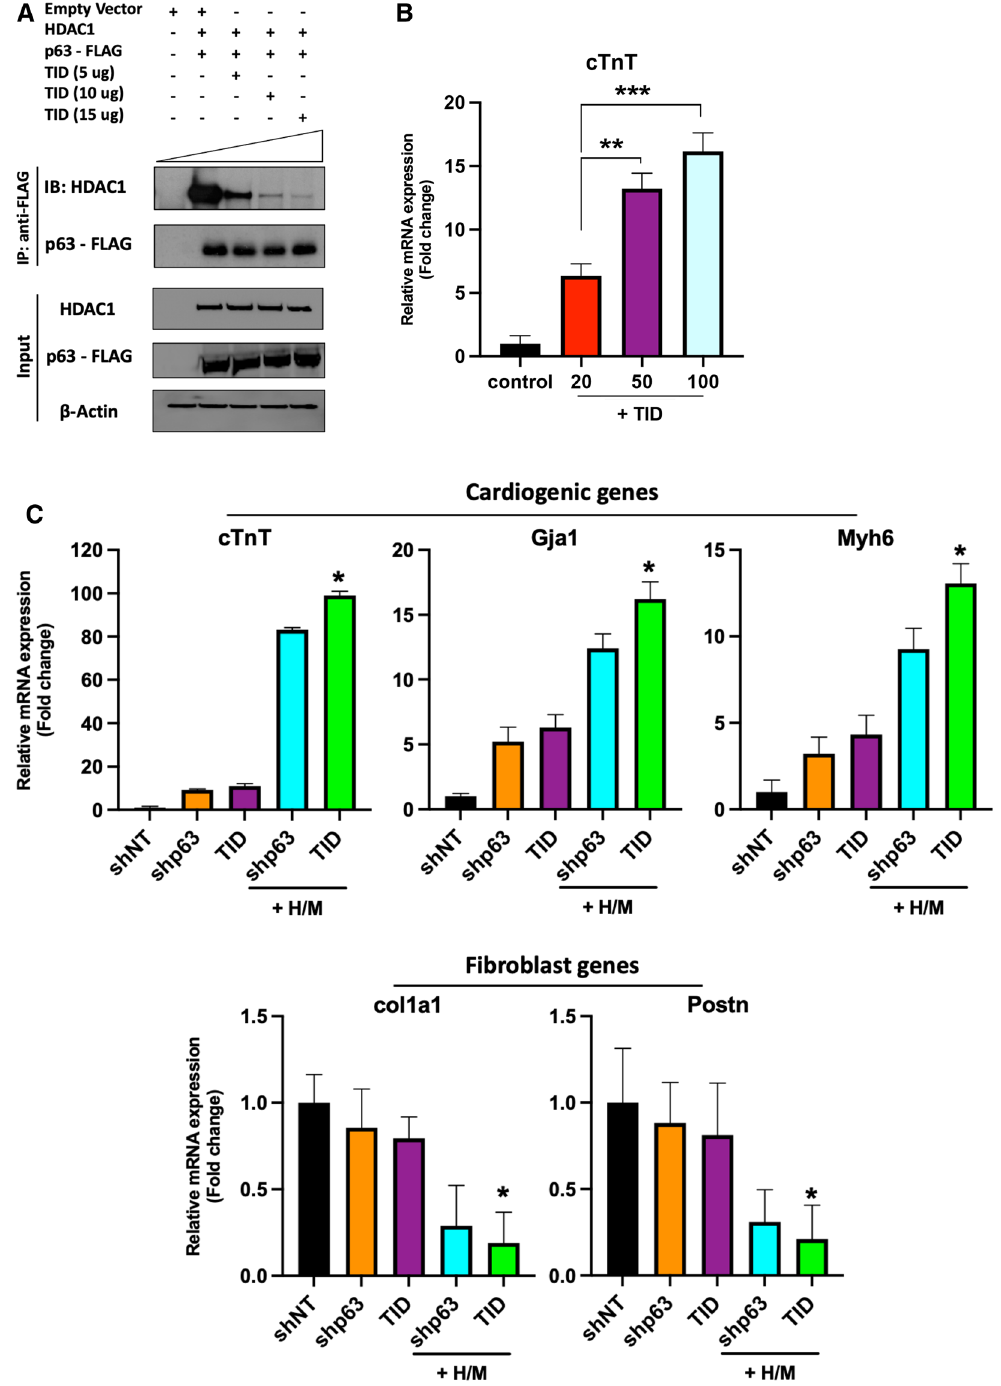
Figure 6. Dose-based efficacy of p63-TID vs shp63 in enhancing human cardiac reprogramming. ( A ) FLAG co-immunoprecipitation assay in 293T cells transfected with HDAC1, p63-FLAG and/or p63-TID vectors at three different p63-TID dosages showing increasing interference in p63-HDAC1 binding as a function of p63-TID dosage. Beta-actin was used as loading control. IB immunoblot, IP immunoprecipitation. ( B ) Dosage screening of p63-TID in human cardiac fibroblasts, qRT-PCR analysis of cardiac Troponin T (cTnT) marker 2 weeks after human cardiac fibroblasts were treated with 20, 50 or100 MOI of lentiviral vector expressing p63- TID (n = 3; ***p < 0.001, **p < 0.01). Control: lentiviral GFP vector, 20 MOI. ( C ) Cardiomyocyte and fibroblast marker gene expression in human cardiac fibroblasts as assessed by qRT-PCR two weeks after indicated treatments using p63-TID vector at a multiplicity of infection (MOI) of 50 (n = 3, H/M = 20 MOI; *p < 0.05 versus shp63+